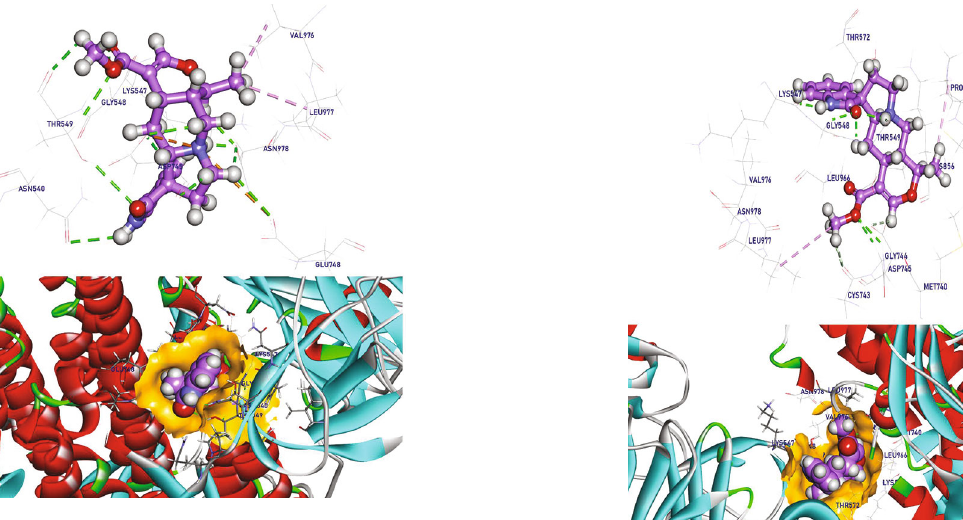
Figure 8: Isopteropodine docked in RBD-SARS-CoV-2 Omicron spike protein, hydrogen bonds (green), and the pi interactions are represented in purple lines with mapping surface showing isopteropodine occupying the active pocket of RBD-SARS-CoV-2 Omicron spike protein.